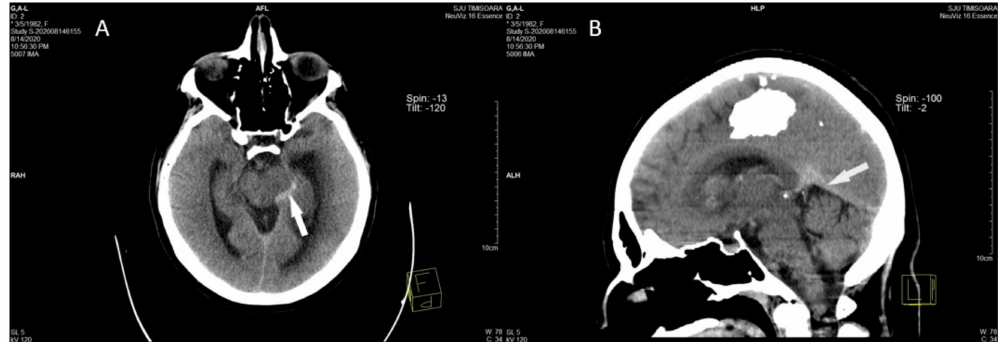
Figure 1. The axial ( A ) and MPR sagittal ( B ) non-contrast head computed tomography performed in the acute phase show the hyperdense appearance (acute thrombosis) of the left lateral mesencephalic vein (arrow in A ) in the straight sinus and Galen vein (arrow in B ).